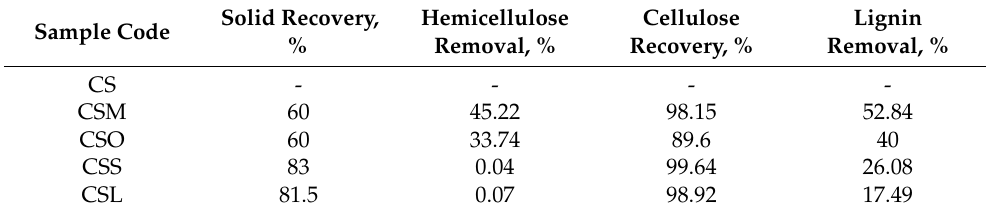
Figure 2. Composition of untreated and treated CS with various organic acid pretreatments. The values are based on the total weight of untreated CS using a pretreatment condition of 2% organic acids, 120 °C under 45 psi at autoclave for 1 h of residence time. Table 1. Composition of raw and pretreated biomass.